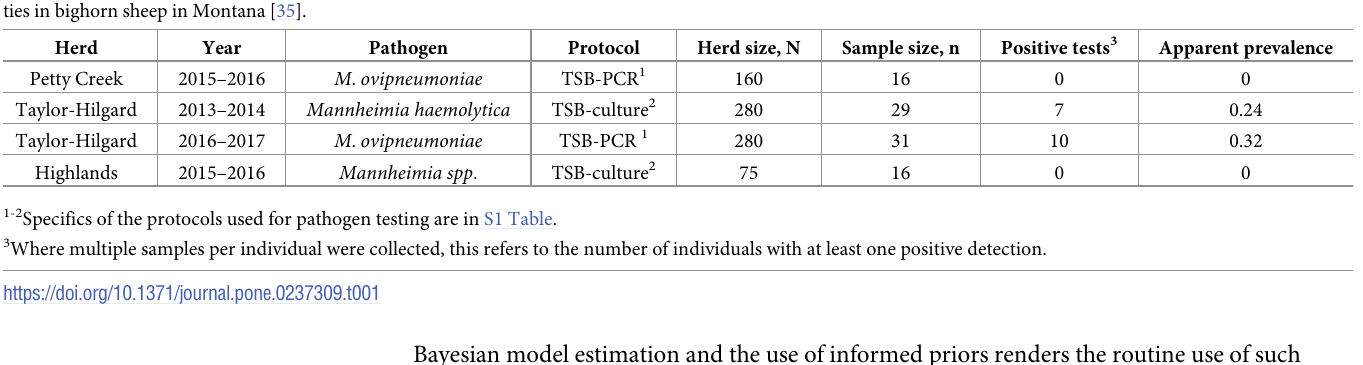
Table 1. Sampling summary for the examples used from bighorn sheep in Montana. These results are taken from a comprehensive assessment of pathogen communi- ties in bighorn sheep in Montana [35].